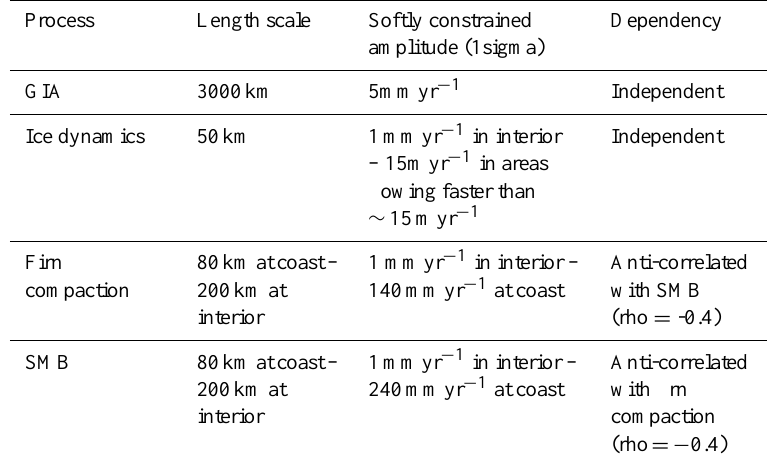
Table 2. Prior information and soft constraints applied to length scales and amplitudes based on expert judgement and analysis of the forward models discussed in Sect.